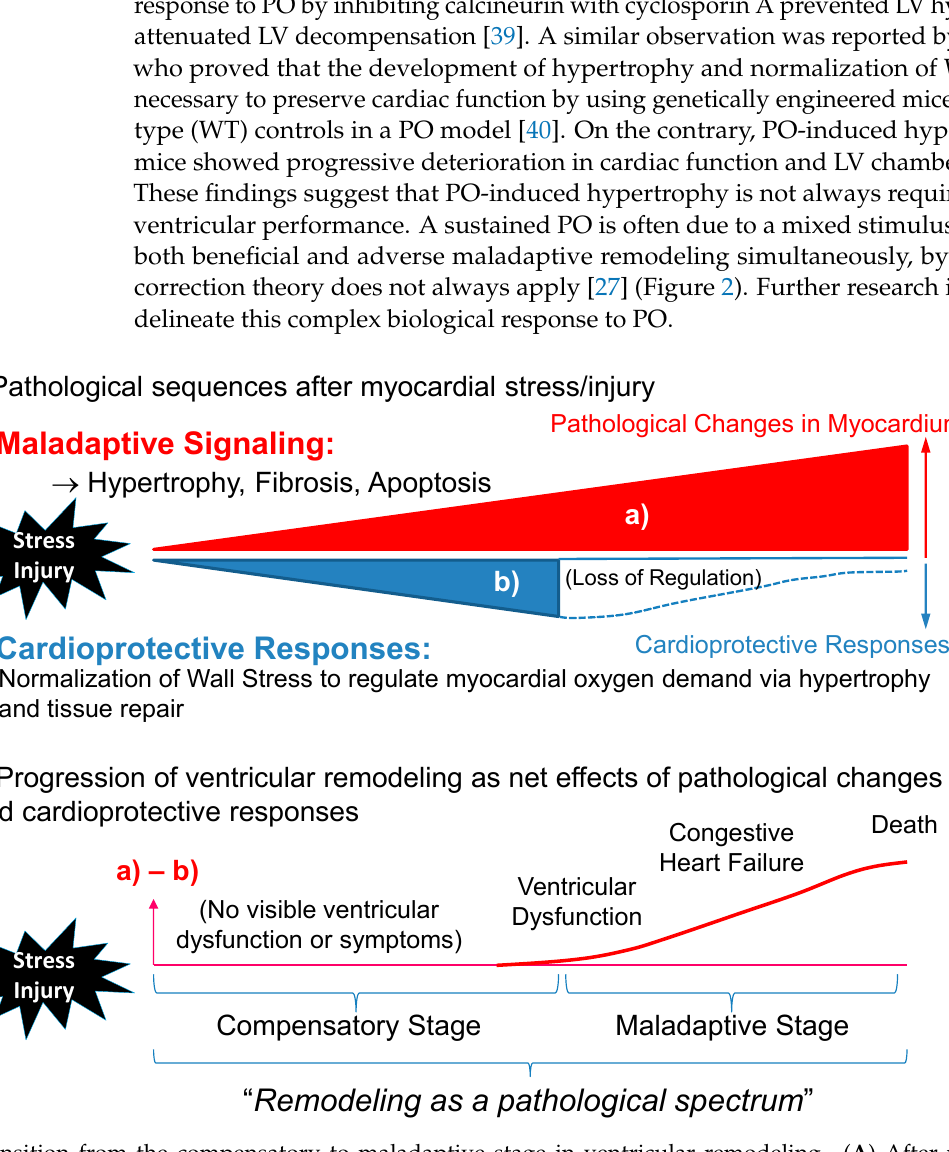
Figure 2. Transition from the compensatory to maladaptive stage in ventricular remodeling. ( A ) After myocardial stress or injury, ventricular myocardium is exposed to both (a) pathological changes and (b) cardioprotective responses. ( B ) Progression of ventricular remodeling may be presented as net effects of (a) pathological changes and (b) cardioprotective responses. Thus, ventricular dysfunction may be masked by initial compensatory cardioprotective responses (hypertro ‐ phy) despite activation of the multiple maladaptive signaling pathways induced by persistent abnormal myocardial stretch or biomechanical stretch. The net outcome between maladaptive and cardioprotective responses may determine the overall ventricular dysfunction and systemic perfusion. It is plausible that pathological alteration is already initiated in the early phase and that the maladaptive phase commences when compensatory responses fail to normalize wall stress (Figure 1). 4. Clinical Significance of Ventricular Wall Stress Quantification of ventricular WS is important as increased WS plays an integral role in understanding the development and progression of LV remodeling. Ventricular WS is estimated according to Laplace’s law, where the heart is modeled by a sphere using the formula below (P: pressure, r: radius, h: wall thickness). WS = P ‧ r/h Sandler and Dodge [41] approximated LV as a thin ‐ walled ellipsoid and derived the formula into that shown below. WS = P ‧ r 2 /h ‧ (2r + h) Originally, WS was obtained through simultaneous measurement of LV pressure by cardiac catheterization and echocardiographic measurement of LV dimensions [24,42]. Later, systolic blood pressure by cuff measurement was proven to be a reliable surrogate of peak LV pressure, and this enabled us to calculate WS noninvasively with echocardio ‐ graphic measurement and simultaneous cuff blood pressure measurement [42,43]. Reichek et al. showed a close correlation between invasively measured end ‐ systolic LV